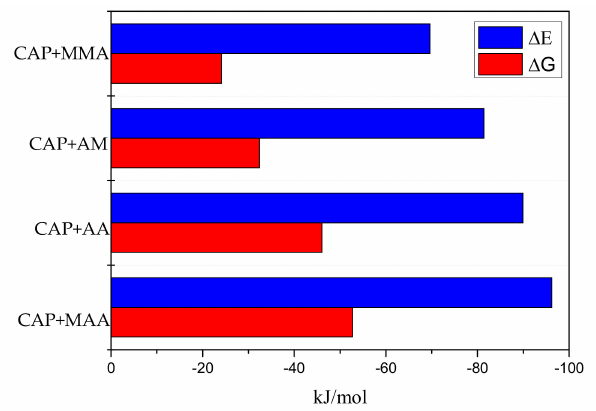
Figure 1. Interaction energies ( ∆ E) and Gibbs free energy changes ( ∆ G) of chloramphenicol + methyl methacrylate (CAP + MMA), chloramphenicol + acrylamide (CAP + AM), chloramphenicol + acrylic acid (CAP + AA), chloramphenicol + methacrylic acid (CAP + MAA)